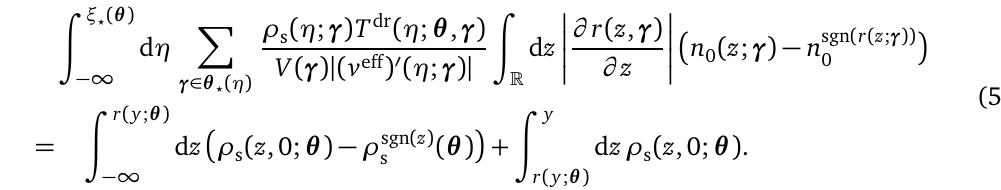
Figure 1: A pictorial representation of how to evaluate the quantity r , given ξ , t , y . Start at the point y , and find the quasi-particle’s rapidity which is such that its tra- jectory joins y with ( ξ t , t ) , in the full problem with initial condition n using the same quasi-particle type and rapidity, evaluate the backward trajectory from ( ξ t , t ) in the partitioning protocol. The value of r is the position obtained at time 0. In this picture, the shade indicates the space-time region where the fluid states in the full problem and in the partitioning protocol are substantially different, thus affecting the